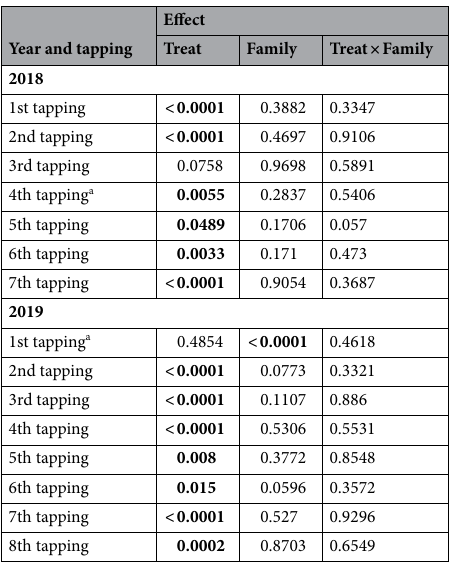
Table 1. Significance levels ( P values) from the analysis of variance conducted on the weekly harvest resin yield with or without resin-stimulating paste treatment. a No resin-stimulating pastes were applied in this tapping. Significant effects ( P value < 0.05) are shown in